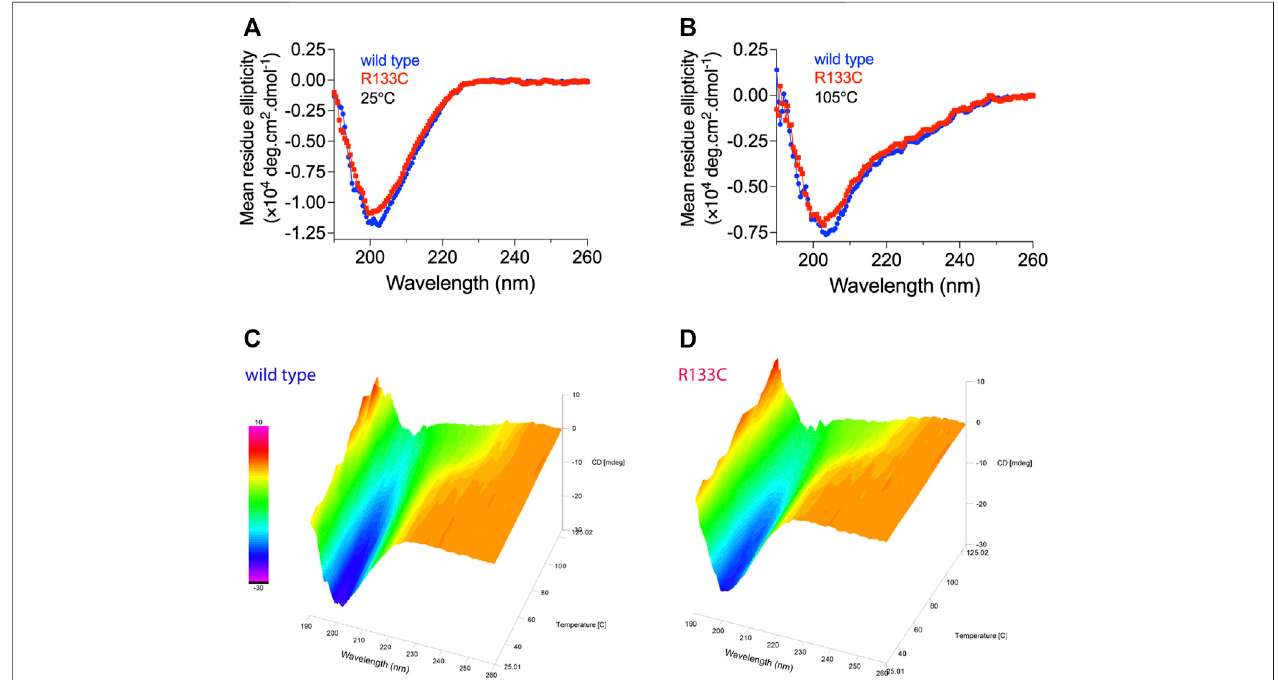
FIGURE 3 | Structural characterization of WT N3 EGF 1 – 5 and R133C mutant. CD spectrum measurements of (A) wildtype N3 EGF 1 – 5 and (B) mutant proteins R133C at 25 ° C and 105 ° C. Continuous CD spectrum measurements of (C) wildtype N3 EGF 1 – 5 and (D) R133C mutant proteins with progressively increased temperature from 25 ° C to 125 ° C with 10 ° C as an